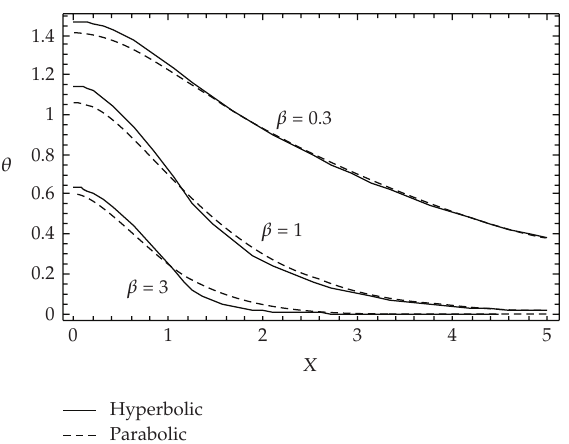
Figure 9: Dimensionless temperature distributions at η (cid:5) 1 for the exponential heat source and various (cid:5) 1 , and U (cid:5) 0 . 1 . values of β ; φ (cid:3) η (cid:4) (cid:5) exp (cid:3) − 0 . 4 η (cid:4) , ψ 0 compared with those obtained from an analytical model by Lewendowska (cid:7) 21 (cid:8) . For U (cid:5) 0, our results are the same as those reported by Lewendowska (cid:7) 21 (cid:8)